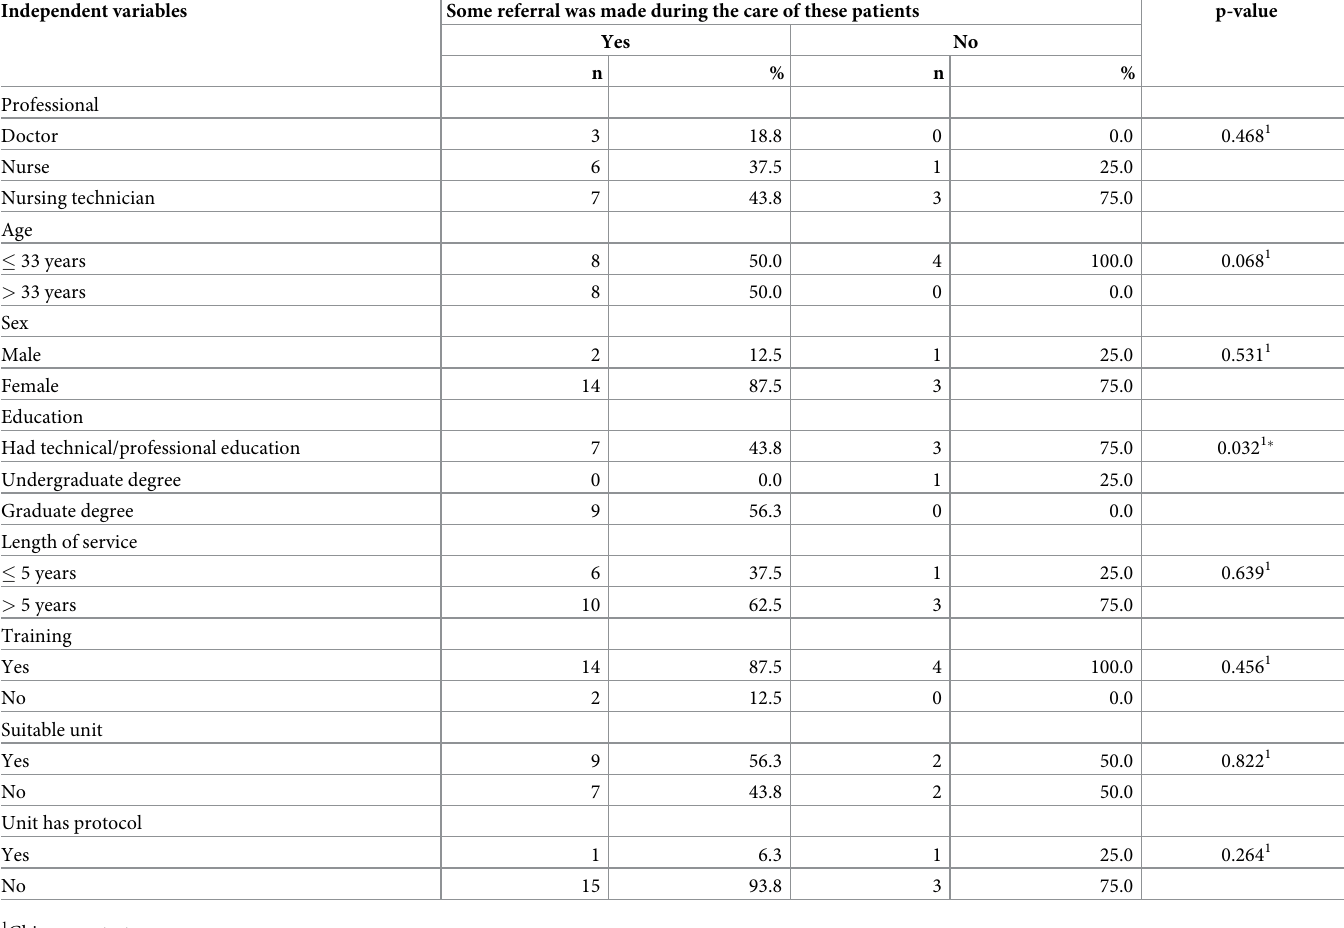
Table 1. Associations between forwarding and independent